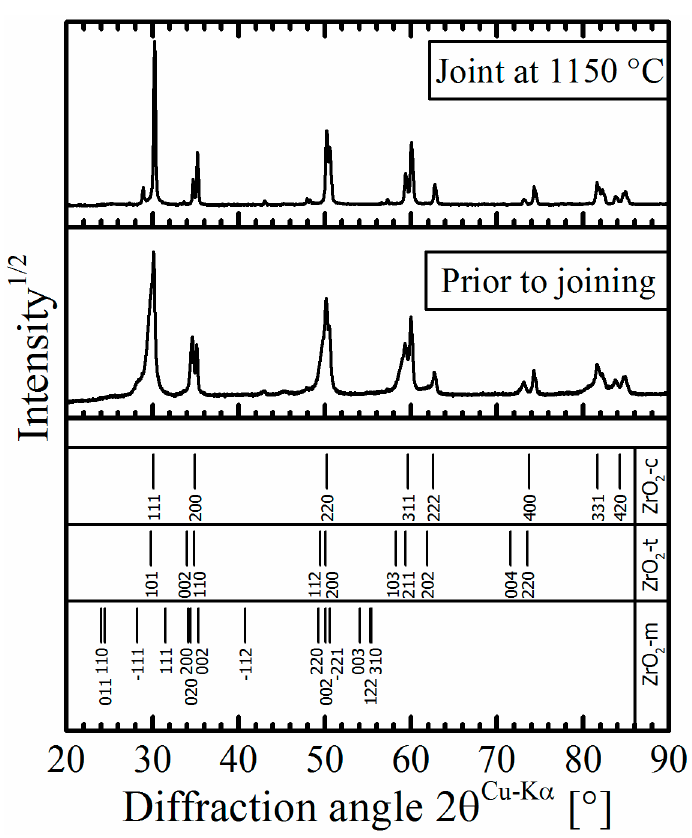
Figure 6. Representative XRD patterns of (3Y)-TZP taken before and after joining at 1150 °C.